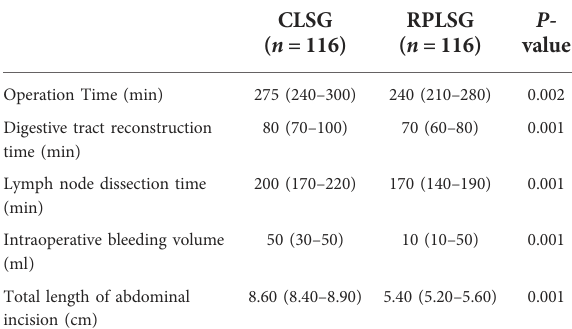
TABLE 1 Preoperative patient demographic information.